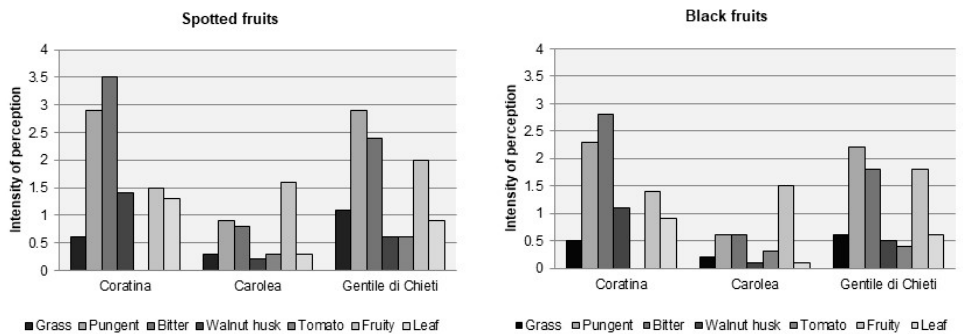
Figure 4. Sensory profiles of oils from Coratina, Carolea and Gentile di Chieti cultivars, at two different